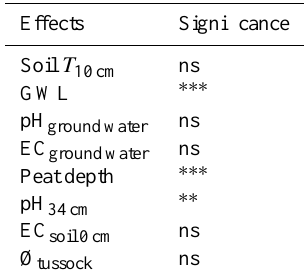
Table 5. Significant effects of the relationship between methane (CH 4 ) emission rate and the measured factors that remained in the model after exclusion of model effects based on Variance Inflation Factors